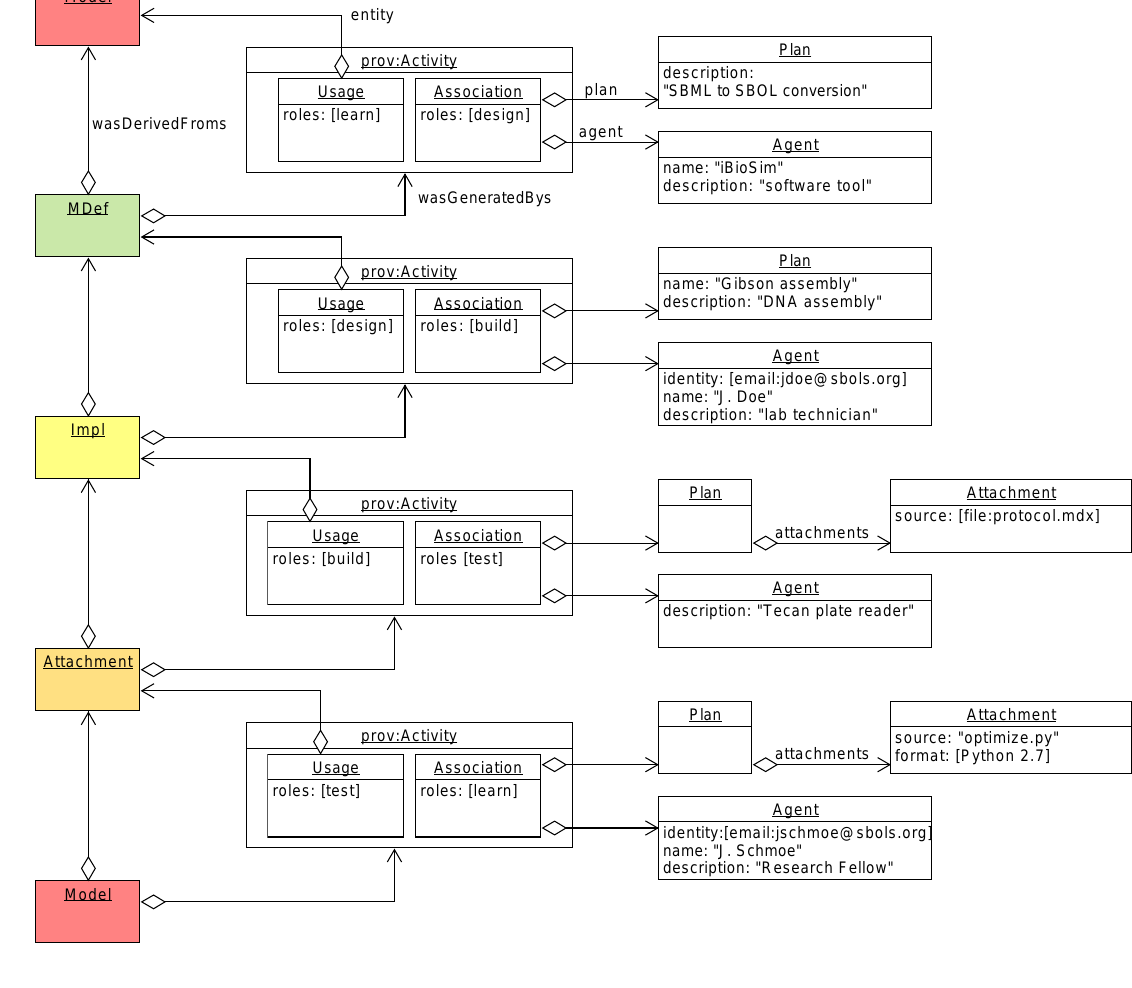
Figure 34: An example data structure representing an idealized workflow for model-based